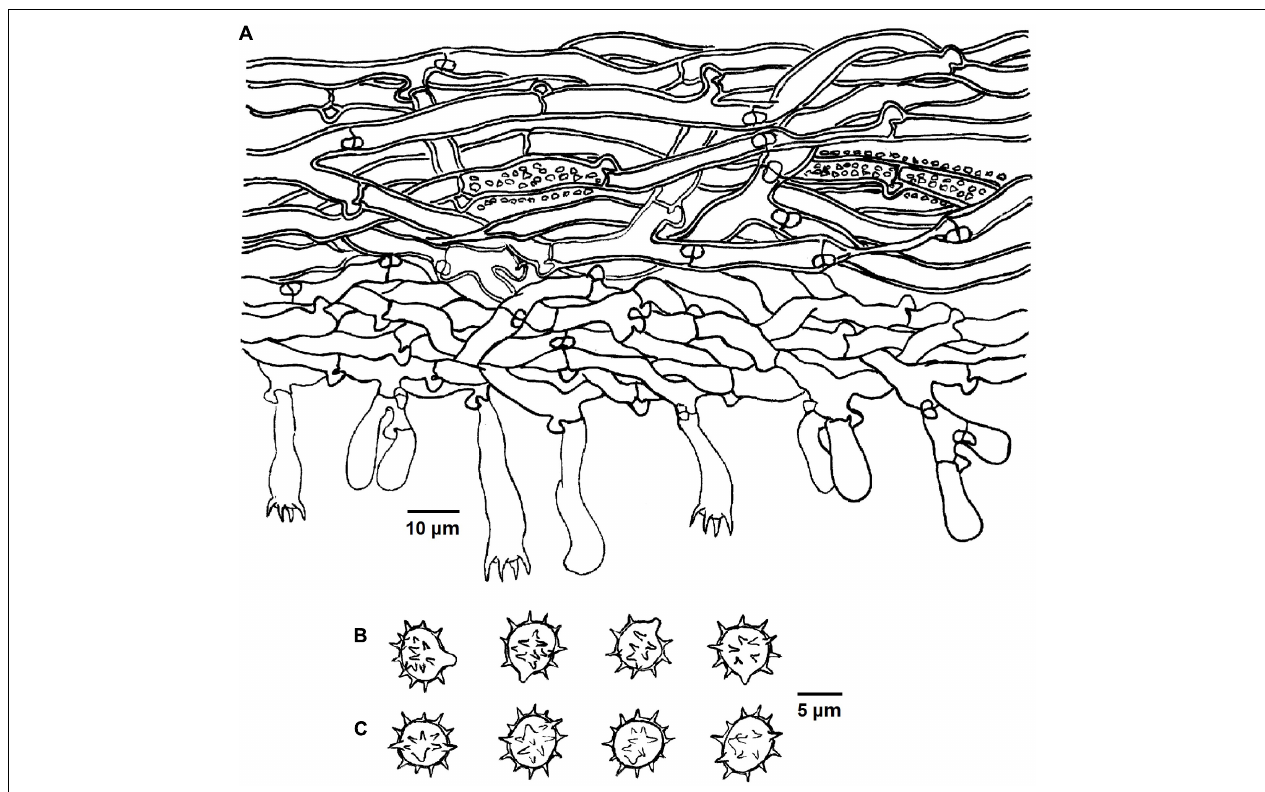
FIGURE 6 | Microscopic structures of Tomentella cinereobrunnea (drawn from Yuan 12703). (A) A section through basidiocarp. (B) Basidiospores in lateral view. (C) Basidiospores in frontal view.